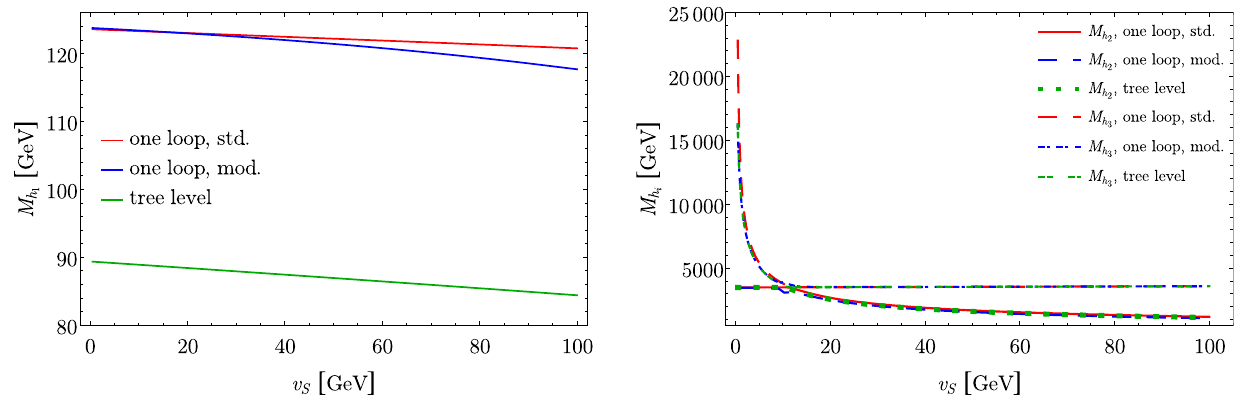
Fig. 10 M h (left) and M h and M h (right) as a function of the soft trilinear coupling T λ , in scenario 2. The values of the other BSM parameters 1 2 3 are taken as in Table 1